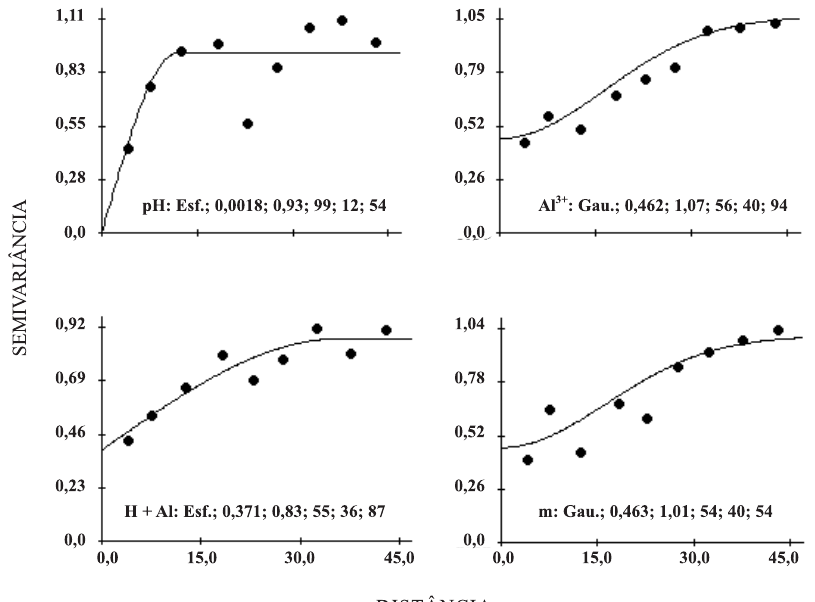
Figura 4. Modelos e parâmetros (C químicos do